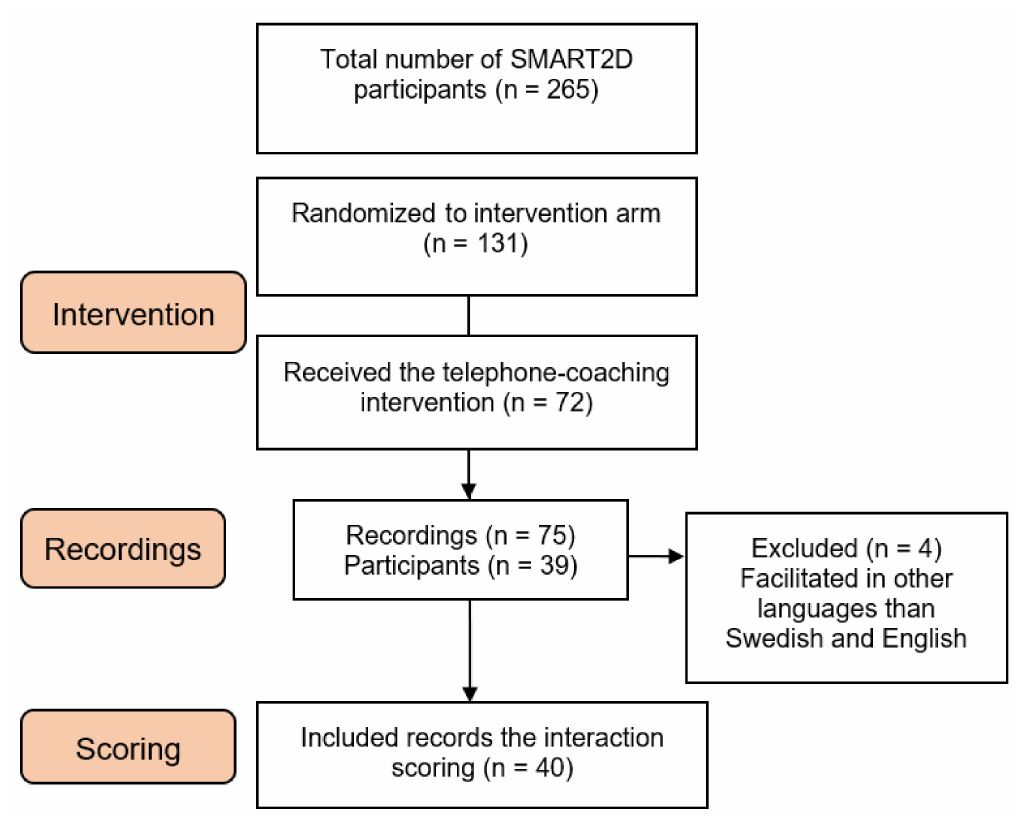
Figure 2. Flow chart describing sampling of SMART2D participants and recordings for the interaction